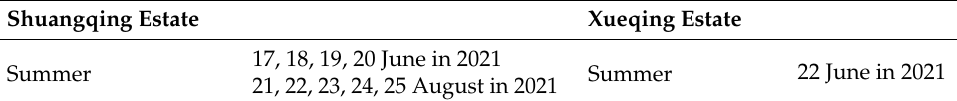
Table 4. Measured